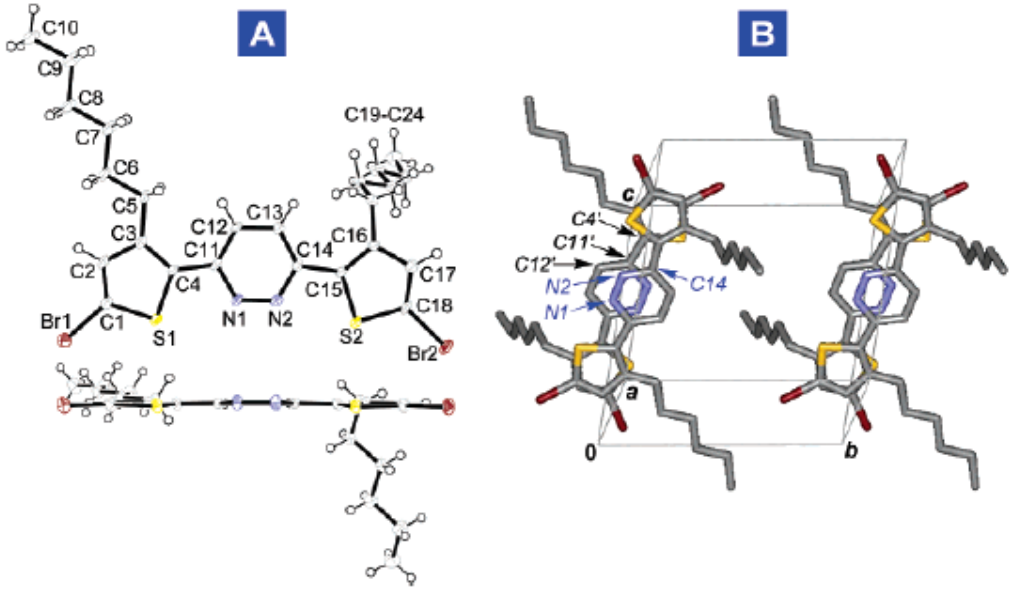
Figure 9. (A) ORTEP drawing and (B) crystal packing diagram of the monomer building block of P(PydTh)-6 copolymer. Reproduced with permission from reference [36]. Copyright 2005 American Chemical